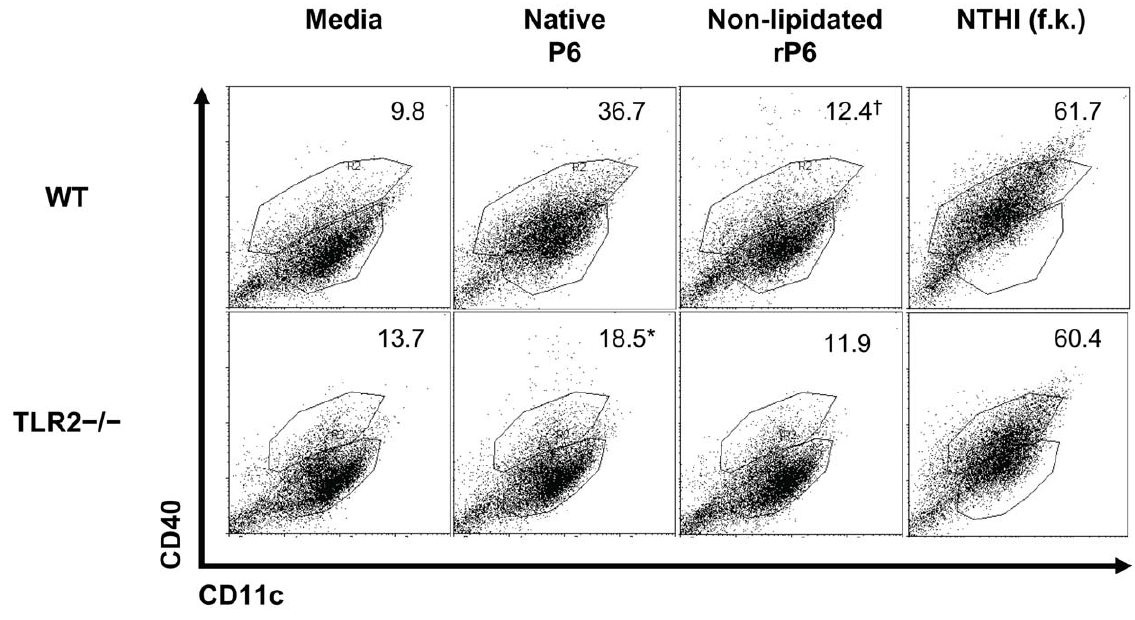
Figure 6. TLR2 expression on APC mediates upregulation of CD40 in response to lipoprotein P6. BMDCs from WT (top row) and TLR2 2 / 2 (bottom row) mice were incubated overnight with the indicated stimuli. Cells were harvested and stained with anti-CD11c and anti-CD40 and acquired by two-color flow cytometry (FITC vs PE) to determine CD40 expression patterns. Percent of cells expressing CD40 over isotype are provided in each plot. *p , 0.05 2way ANOVA with Bonferroni post-test comparison of native P6 between WT and TLR2 2 / 2 . { p , 0.05 2way ANOVA with